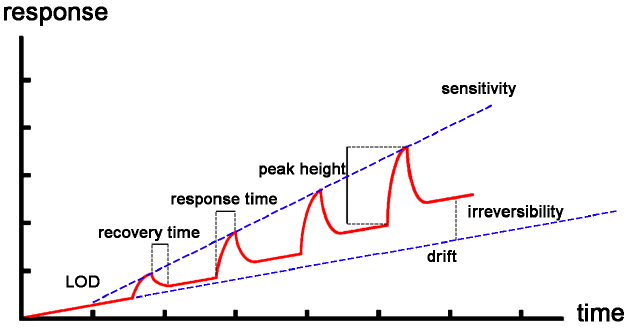
Figure 3. Selected performance parameters of a device which is exposed to a rising concentration of analytes. Cited from Reference [24] with permission.